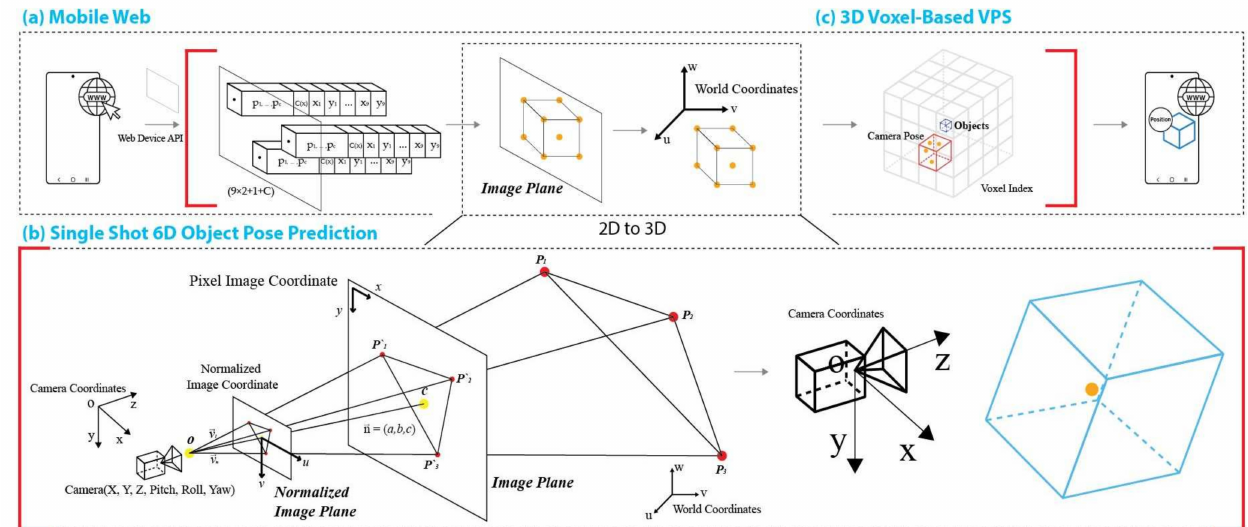
Figure 1. Overview of the proposed visual positioning method (system) (VPS). The process comprises ( a ) pose estimation stages of extended single-shot deep CNN; ( b ) estimate the 6D pose from the correspondences between the 2D and 3D points using a PnP pose estimation method; and ( c ) mobile web with voxel indexing through